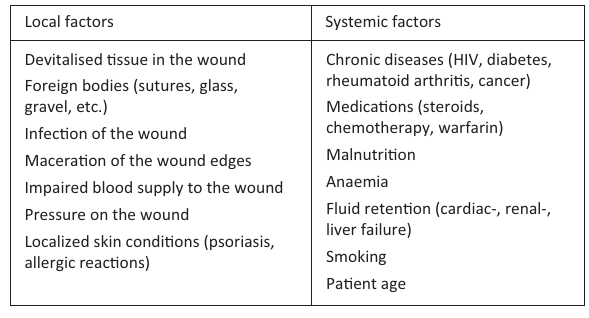
FIGURE 1: Common local and systemic factors that may delay wound